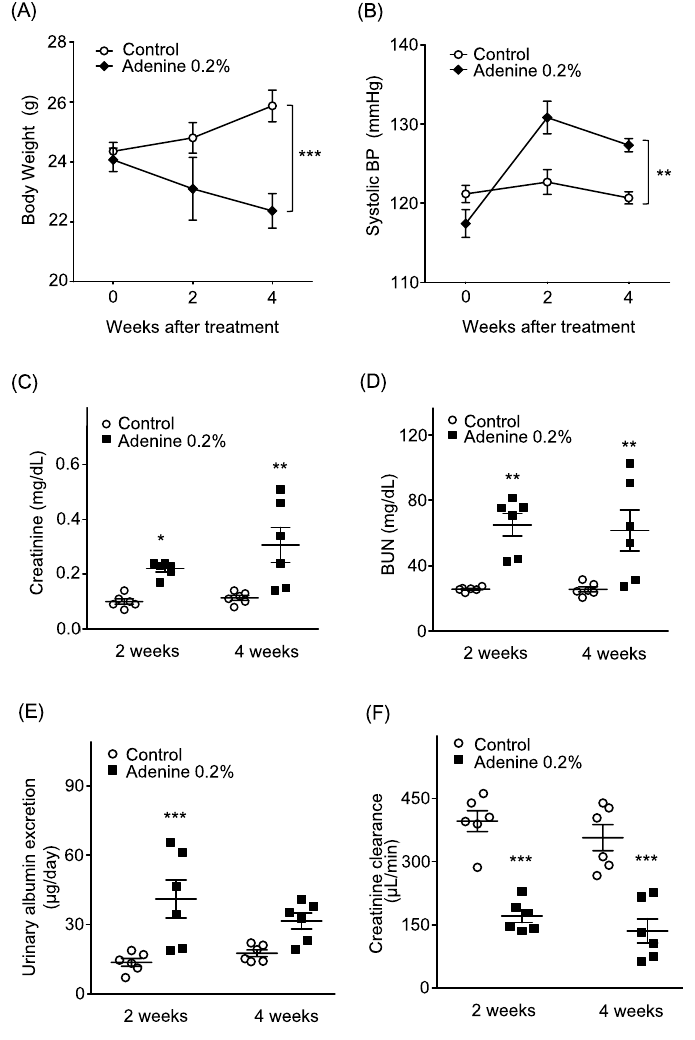
Figure 1. Body weight, blood pressure, and renal functions in adenine-induced CKD model mice. ( A ) Body weight changes in control and adenine groups. ( B ) Systolic blood pressure in control and adenine groups at 0, 2, or 4 weeks after treatment. ( C ) Plasma creatinine level, ( D ) BUN level, ( E ) urinary albumin excretion, and ( F ) creatinine clearance were measured at 2 or 4 weeks after treatment in both control and adenine groups. Values are expressed as mean ± standard error of the mean (six mice per group). P values, versus control: * P < 0.05; ** P < 0.01; *** P < 0.001. CKD, chronic kidney disease; BP, blood pressure; BUN, blood urea